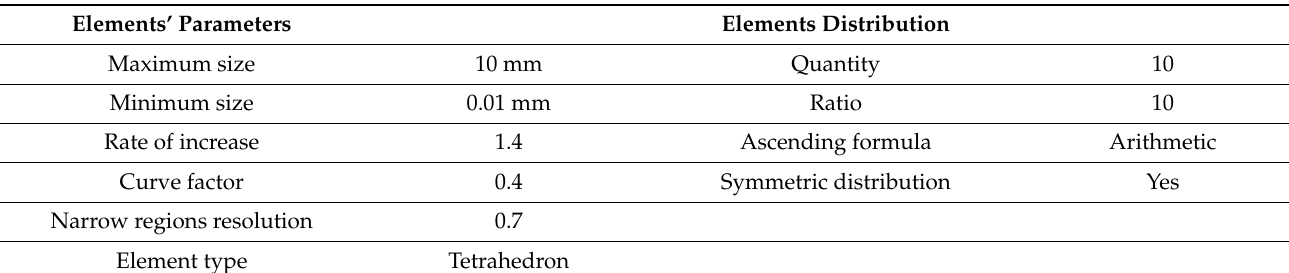
Table A1. Mesh building options when dividing models.